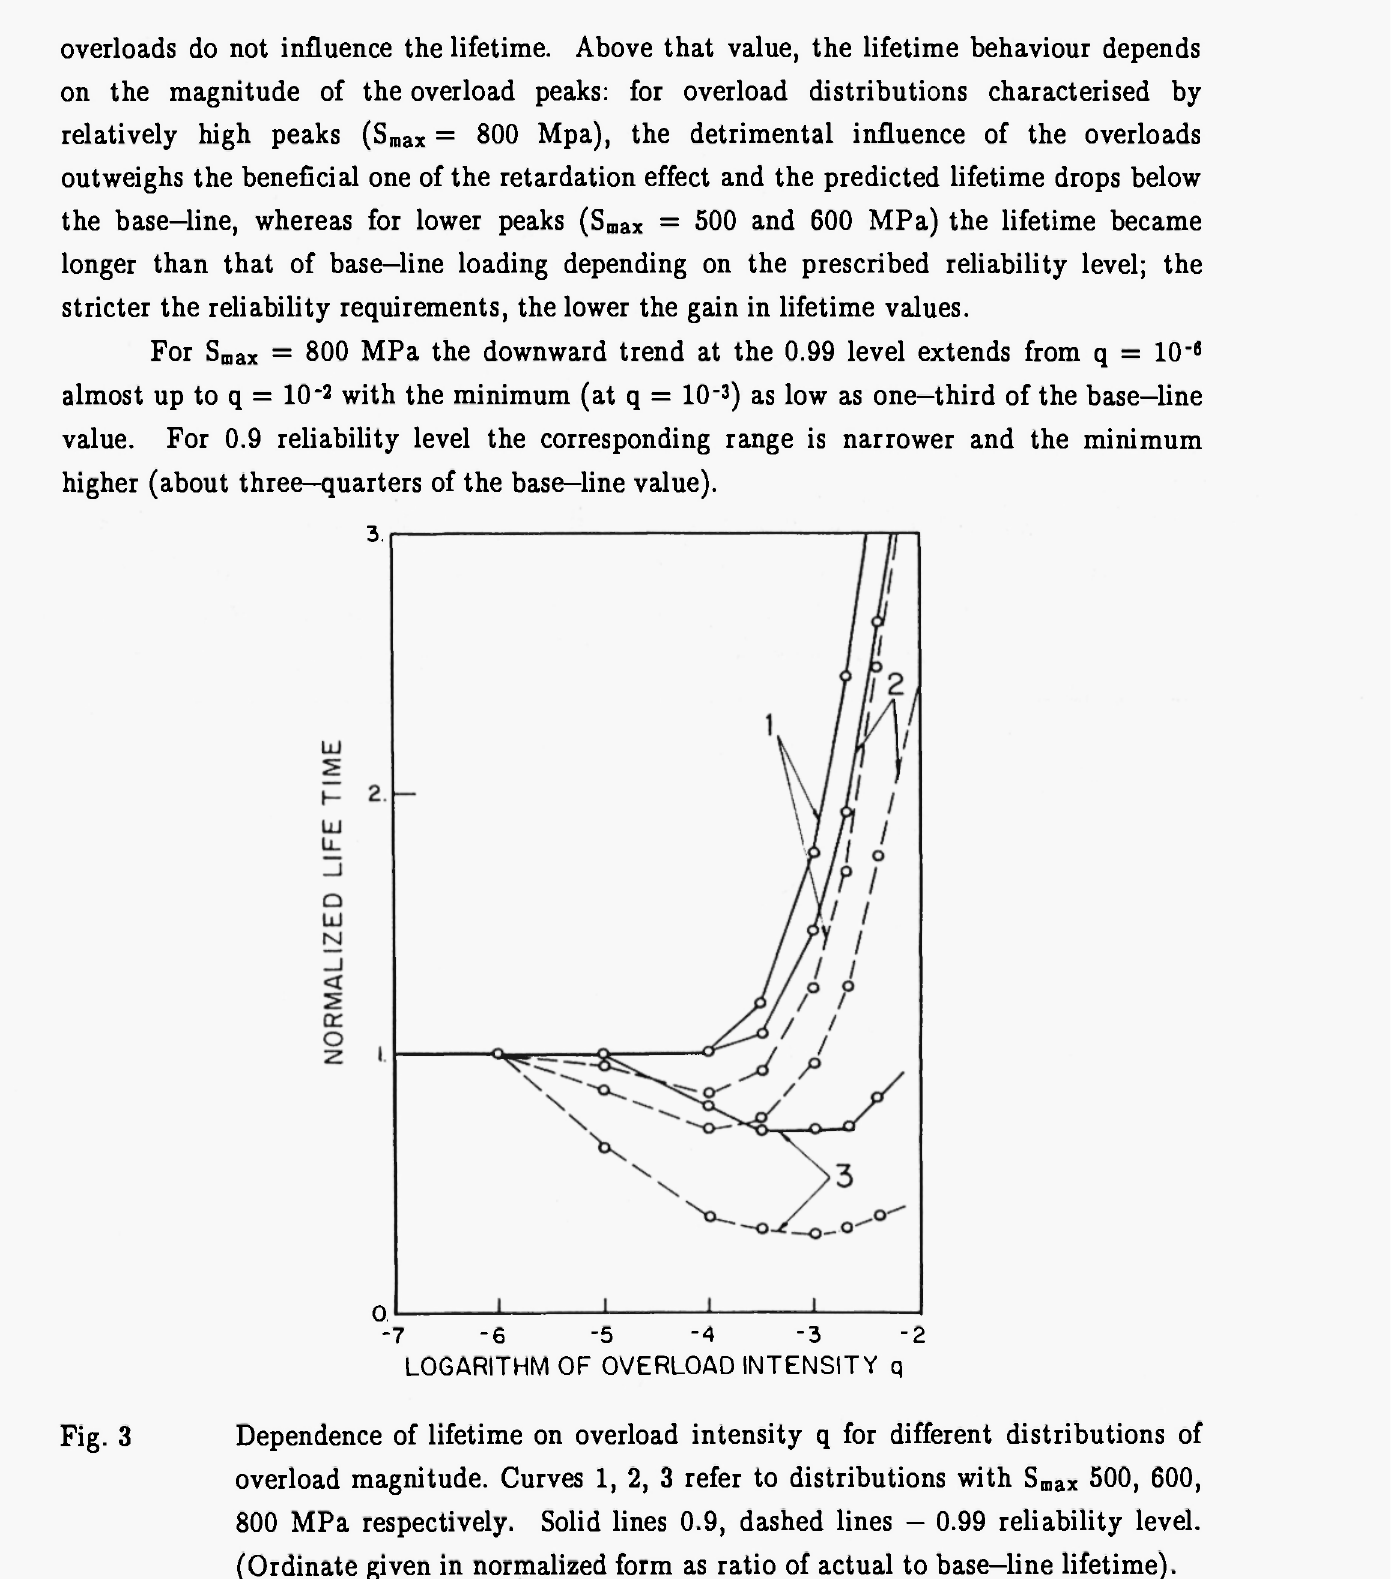
Fig. 3 Dependence of lifetime on overload intensity q for different distributions of overload magnitude. Curves 1, 2, 3 refer to distributions with S ma x 500, 600, 800 MPa respectively. Solid lines 0.9, dashed lines — 0.99 reliability level. (Ordinate given in normalized form as ratio of actual to base—line